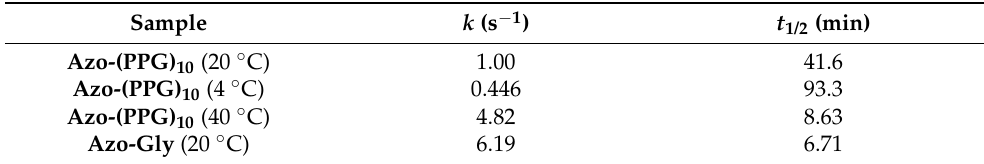
Table 1. Kinetic profile of the isomerization of the azobenzene